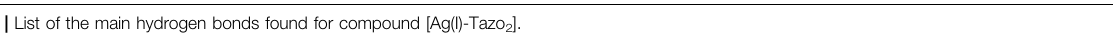
TABLE 1 | List of the main hydrogen bonds found for compound [Ag(I)-Tazo 2 ]. Sym.